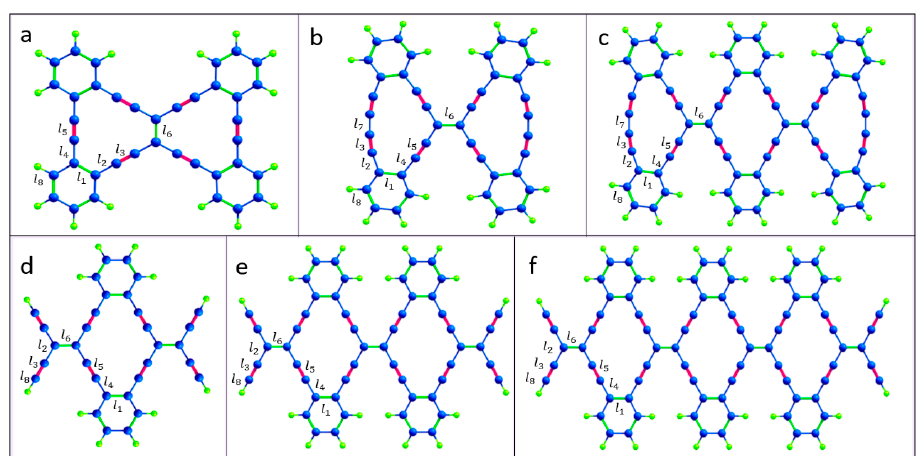
Figure 2. Atomic structure of the isolated 6,6,12-graphyne fragments ( a ) O1, ( b ) O2, ( c ) O3, ( d ) O4, ( e ) O5, and ( f ) O6. The edges are passivated with hydrogen atoms. Carbon and hydrogen atoms are represented by blue and green colors, respectively.